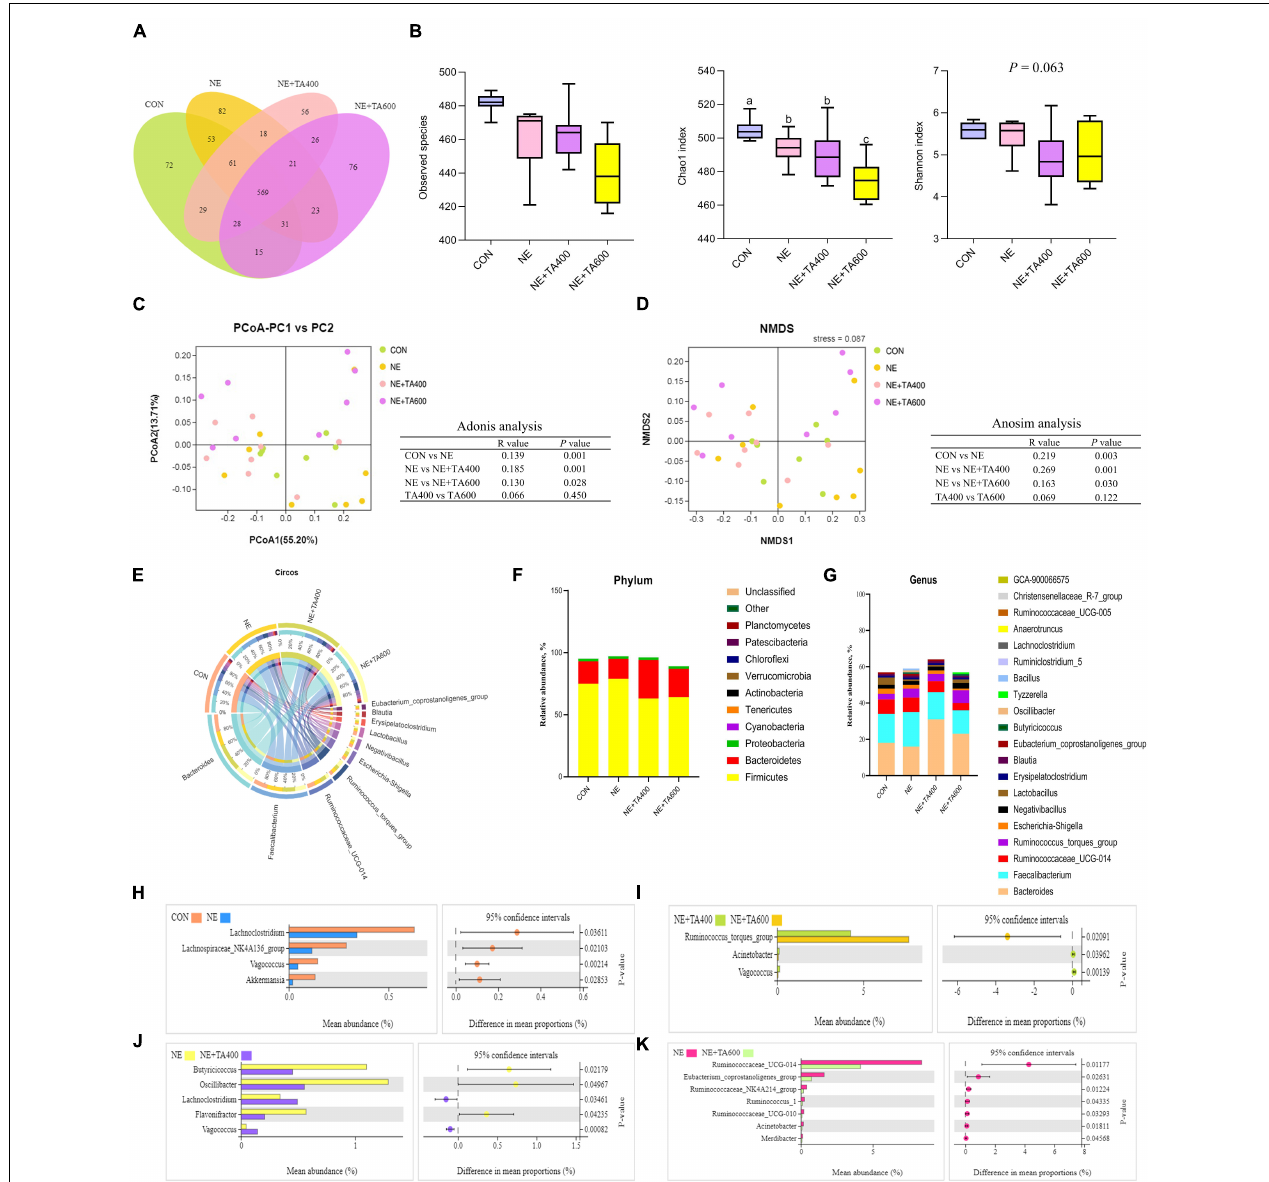
FIGURE 7 | The effects of TA on the cecal microbial composition of subclinical NE broilers ( n = 8). (A) Venn diagram of shared and unique OTUs between groups; (B) alpha diversity index: observed species, Chao 1, and Shannon. a , b Means with different letters differ significantly among the groups ( P < 0.05). (C) Principal coordinate analysis (PCoA) and Adonis analysis based on weighted UniFrac distances among samples; (D) non-metric multi-dimensional scaling (NMDS) and Anosim analysis based on weighted UniFrac distances among samples; (E) In the Circos plot, the upper semicircle represented the relative abundance of each genus per group, and the lower semicircle exhibited the microbial genera composition; relative abundance of microbial community at the phylum (F) and genus (G) levels. Significant differences on phylotypes at the genus level were observed between the CON and NE groups (H) , NE + TA400 and NE + TA600 groups (I) , NE and NE + TA400 groups (J) , and NE and NE + TA600 groups (K) , and Welch’s t- test was conducted to determine the significant difference among the groups. Significant difference among the groups was declared at P <